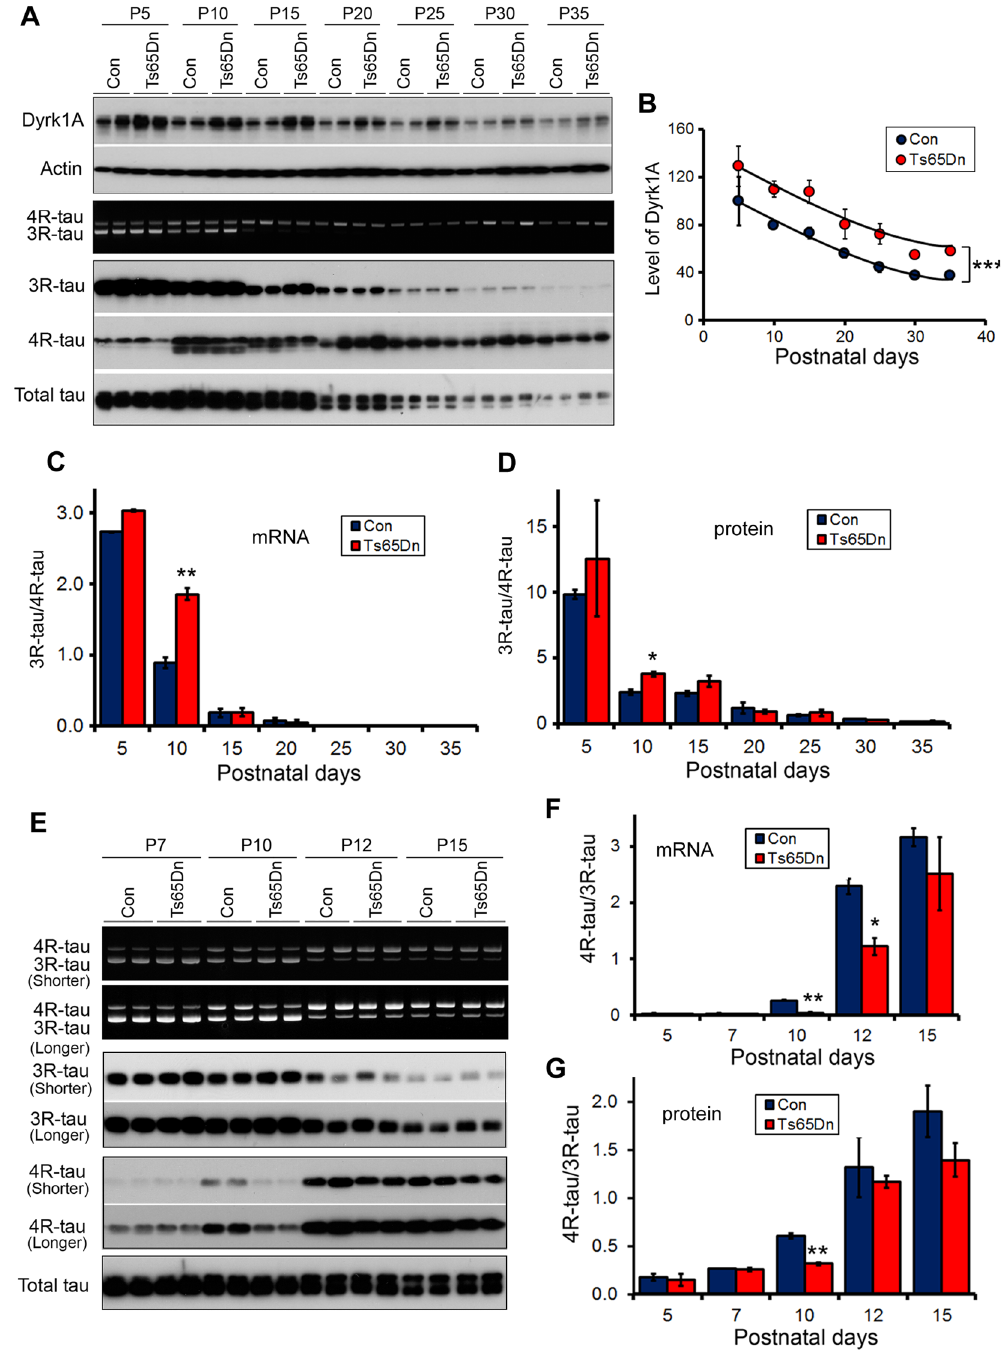
Figure 3. The alternative splicing of Tau exon 10 is dysregulated in neonatal Ts65Dn mouse brains. ( A–D ) Forebrains were collected from Ts65Dn mice and the littermates at P5, P10, P15, P20, P25, P30, and P35. Dyrk1A, 3R-tau, 4R-tau and total tau were analyzed by RT-PCR for mRNA and by Western blots for protein developed with anti-Dyrk1A (8D9), anti-3R-tau (RD3), anti-4R-tau (RD4), and anti-total tau (92e). The levels of Dyrk1A ( B ) and the ratios of 3R-tau/4R-tau at the mRNA ( C ) and the protein ( D ) were calculated. ( E–G ) Mouse forebrains from Ts65Dn and the littermates at P5, P7, P10, P12, and P15 were analyzed 3R- tau, 4R-tau, and total tau by RT-PCR and Western blots with shorter exposure or longer exposure ( E ). The ratios of 3R-tau/4R-tau at the mRNA ( F ) and the protein ( G ) levels were calculated. The Data are presented as mean ± S.D. (n = 3–5) and statistically analyzed with two-way ANOVA followed by Bonferroni post-test. The difference between Ts65Dn and the littermate controls at postnatal day 10 (P10) was analyzed by paired student t test. * p < 0.05, ** p < 0.01, and *** p <